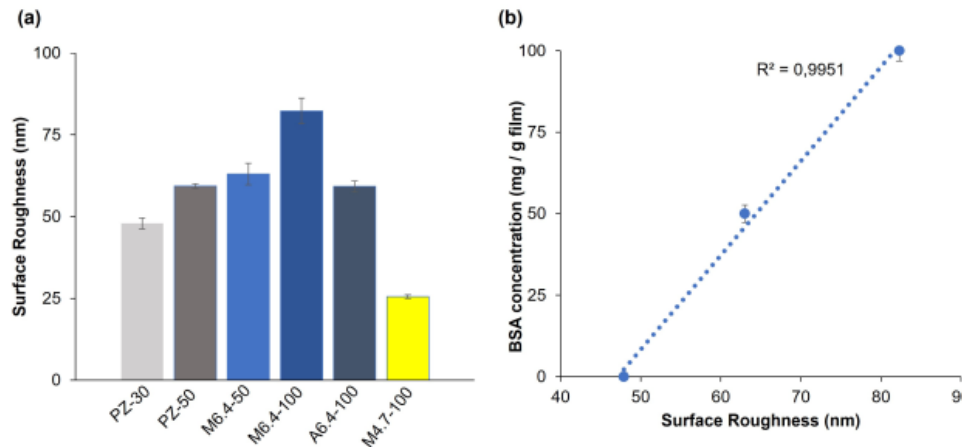
Figure 6. ( a ) Surface roughness of the hydrogel samples, ( b ) variation of surface roughness of M6.4-x hydrogels with BSA concentration.